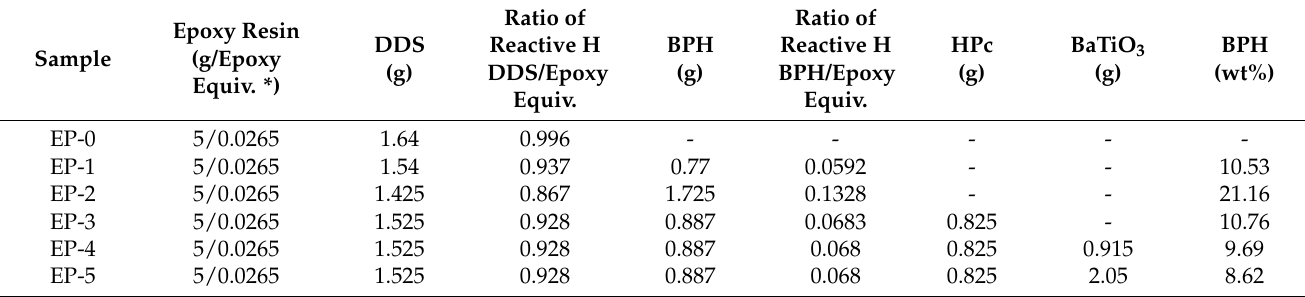
Table 1. Detailed data regarding the ingredients used in the preparation of the epoxy